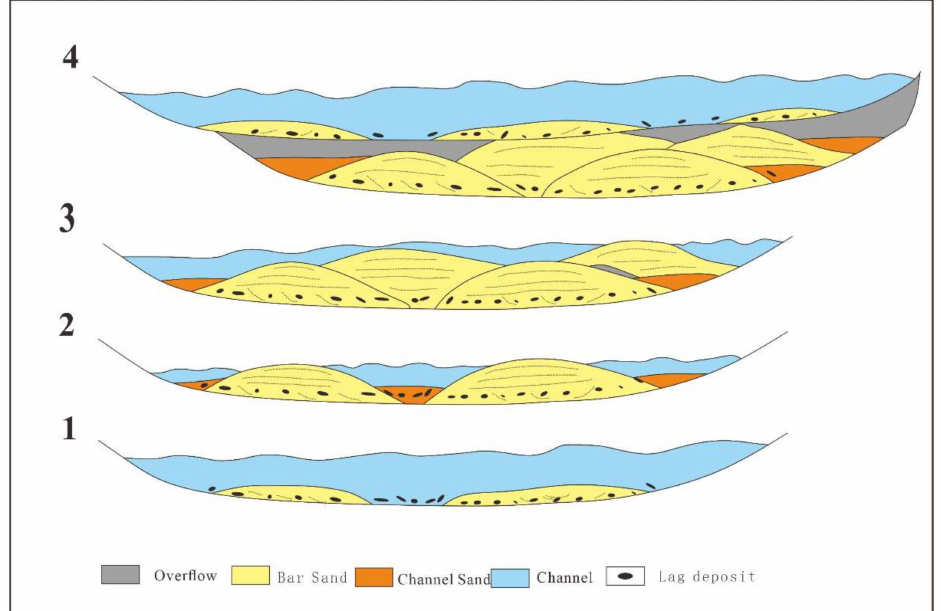
Figure 13. Depositional process of the sandy braided river of Yungang Formation in Datong Basin. 1, 2, 3, 4 indicate the stages of depositional